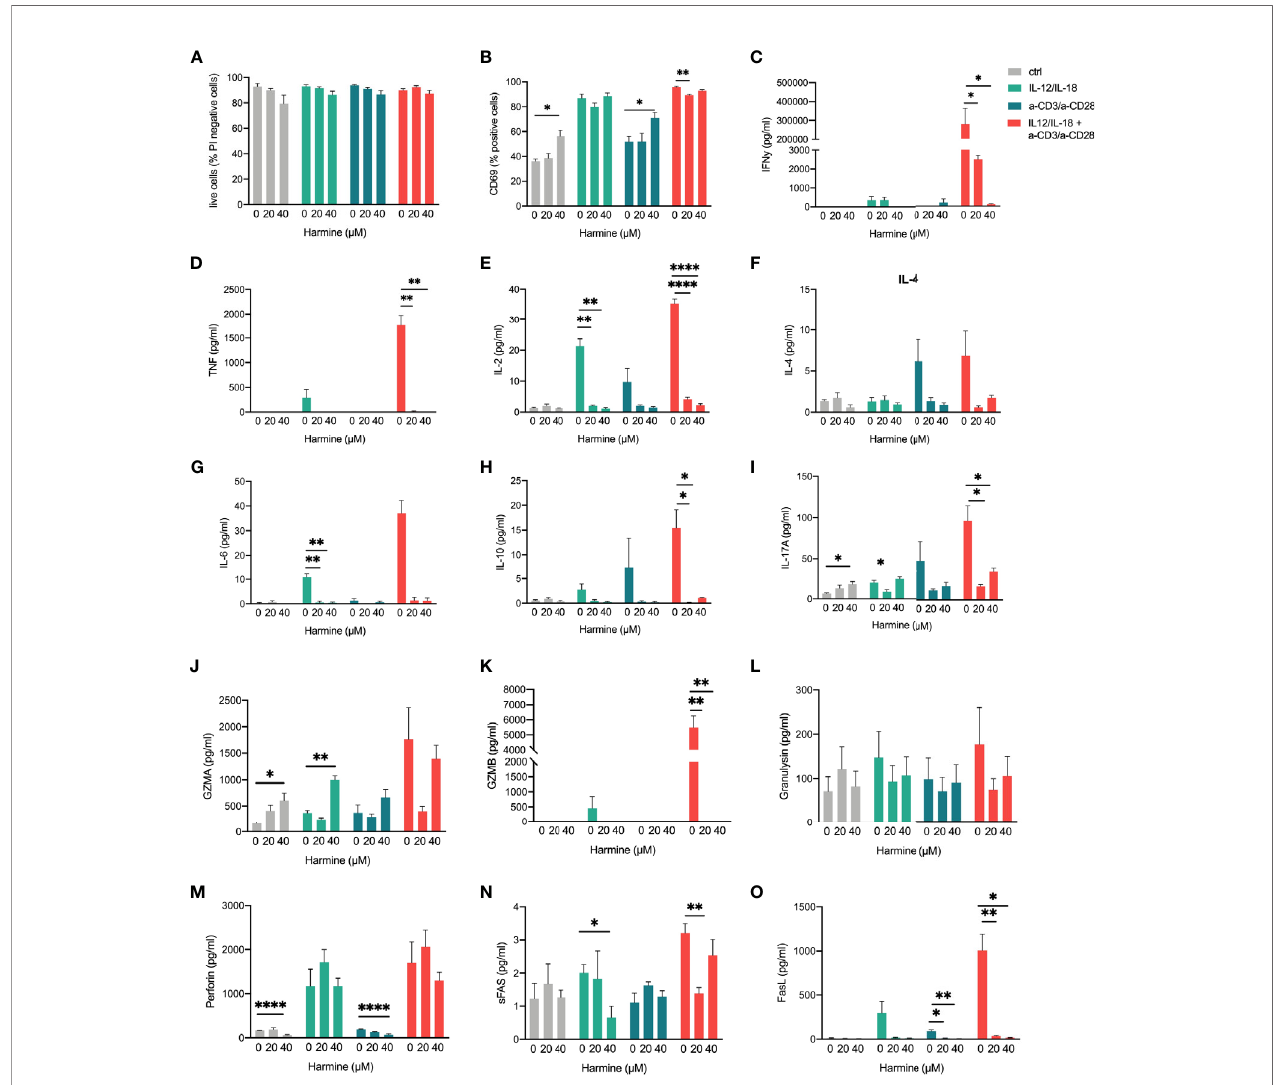
FIGURE 9 | Effects of TWIST1 inhibition in activated MAIT cells. MAIT cells were stimulated with IL-12/IL-18, a-CD3/a-CD28, or a combination of both and (A) cell viability using propidium iodide staining, (B) CD69 cell surface expression using an anti-CD69 antibody as well as cytokine (C – I) or cytotoxic effector molecule release (J – O) using the LEGENDplex ™ Human CD8/NK Panel bead assay were determined by fl ow cytometry (mean +SEM, n = 3). Levels of signi fi cances are given as p-values with **** ≤ 0.0001, *** ≤ 0.001, ** ≤ 0.01 and * ≤